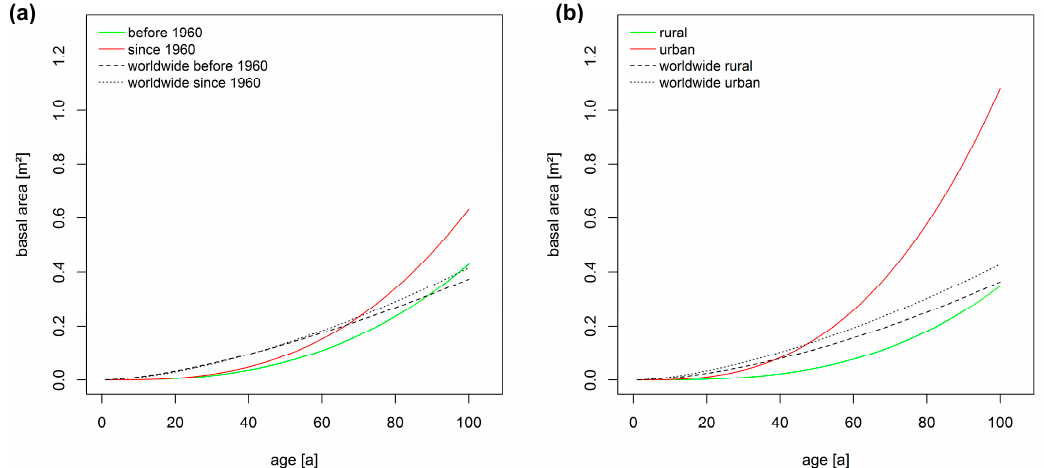
Figure 6. The growth in size in terms of basal area growth of A. sachalinensis in Sapporo and for worldwide urban trees [17] for ( a ) the period before 1960 compared with the period since 1960 and ( b ) urban trees compared with rural growing trees.